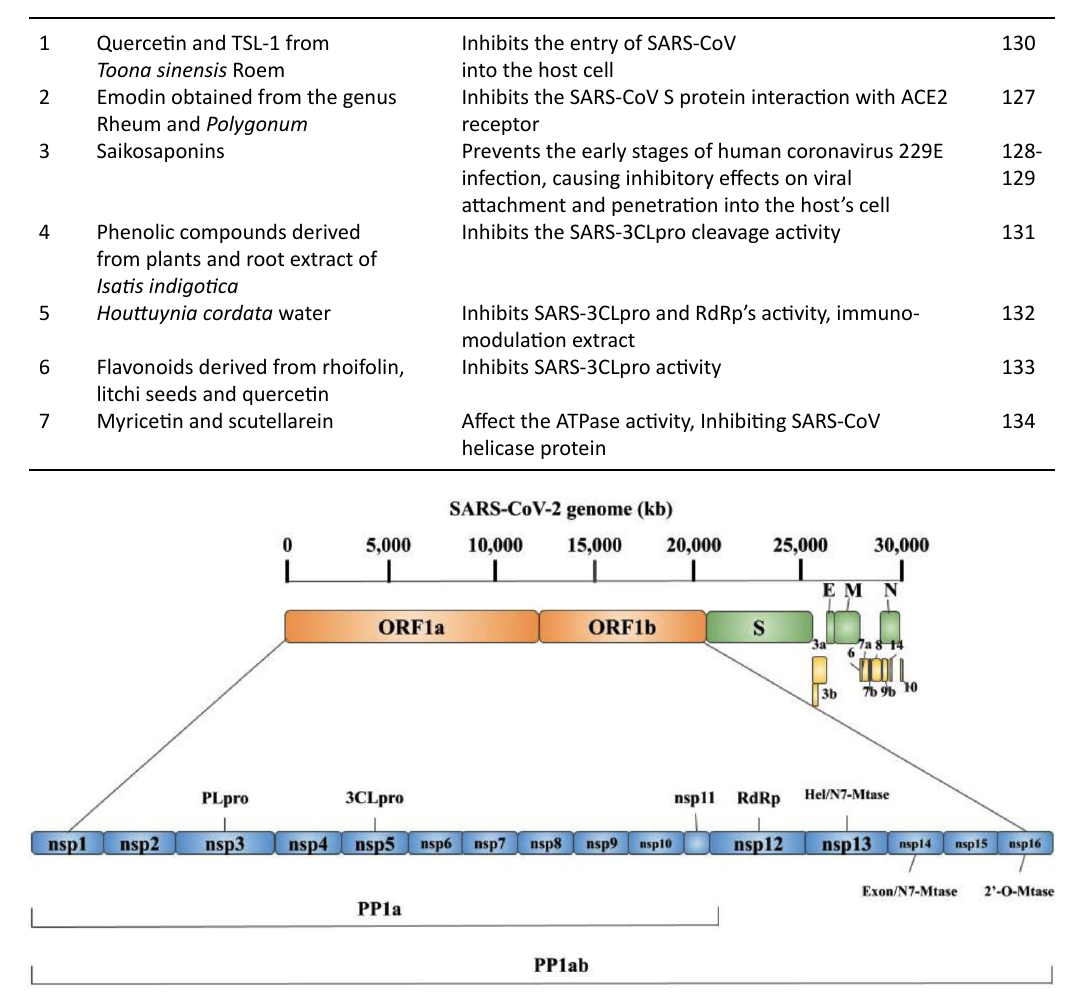
Table 4. TCM derived compounds or extracts with anti-human coronavirus activity No.